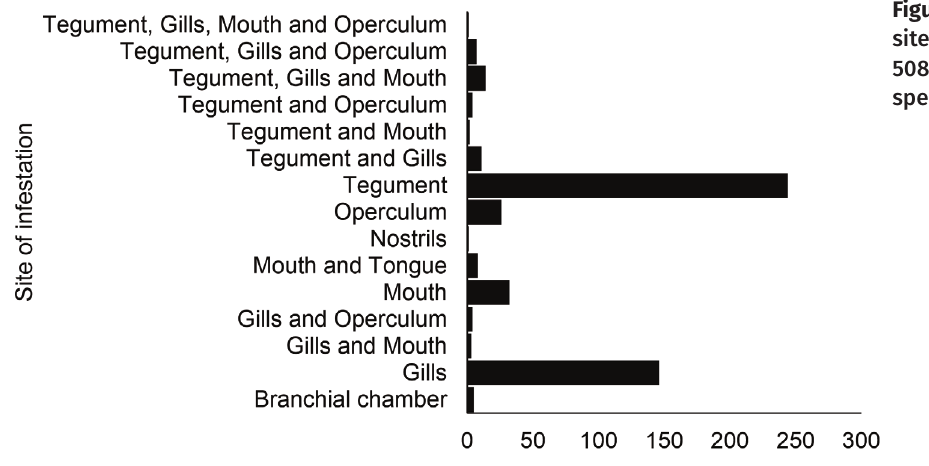
Figure 4. Infestation sites by Caligus spp. in 508 samples for teleost